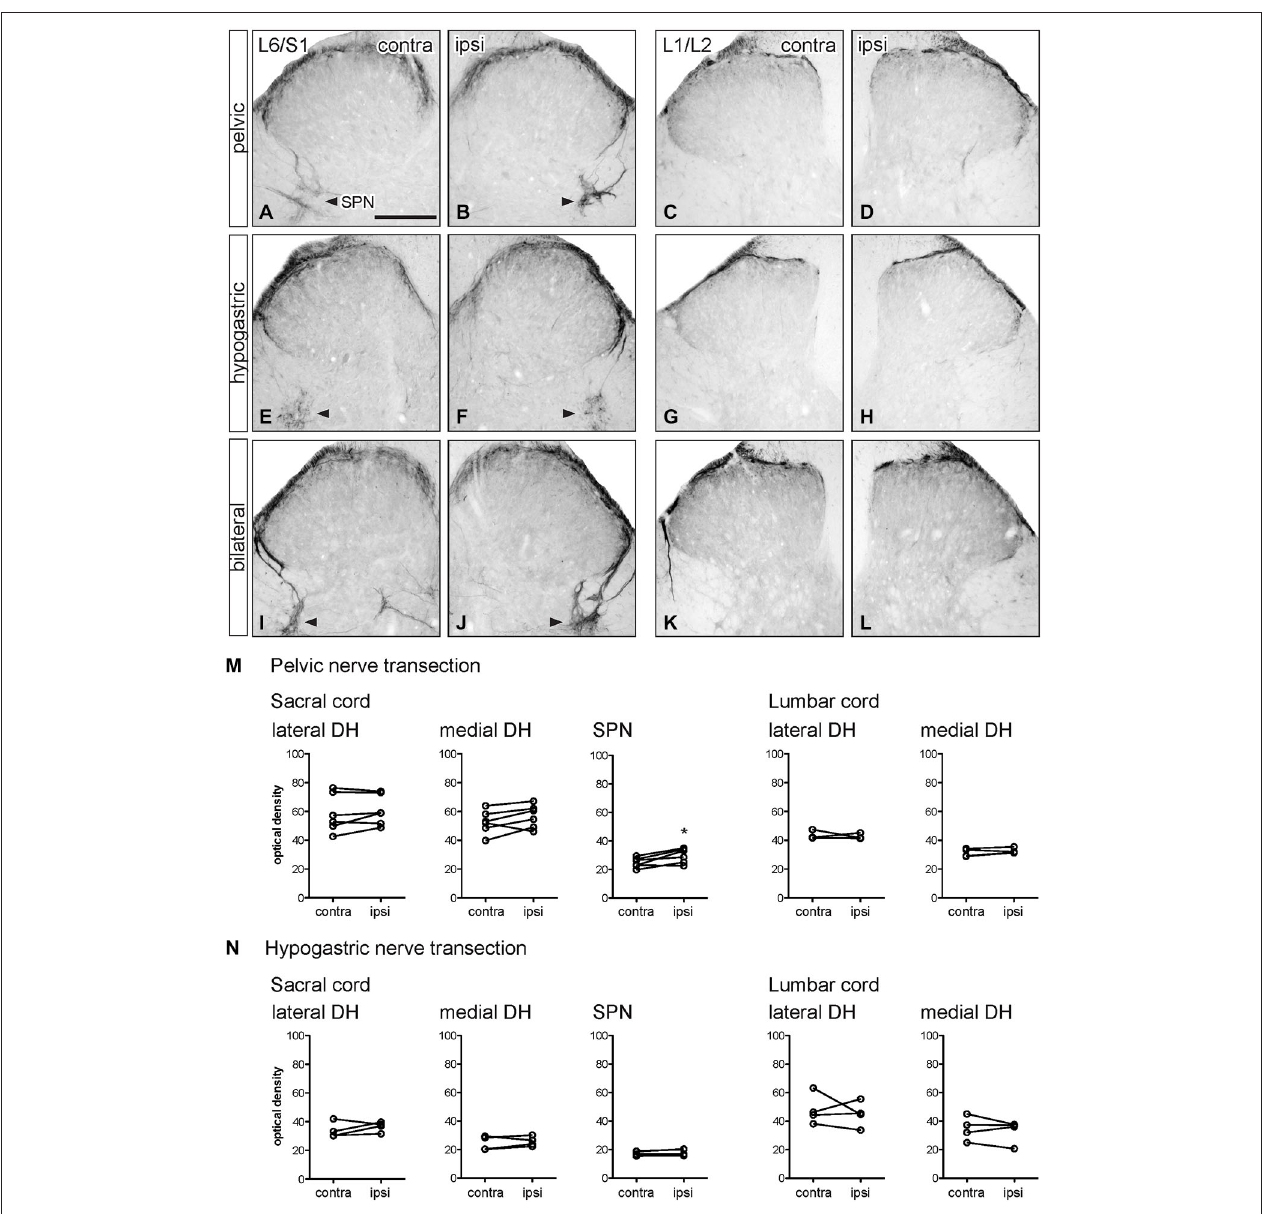
no changes in GFR α 3-IR in sacral dorsal horn, while an increase in GFR α 3-IR was seen in the sacral parasympathetic nucleus (SPN). In lumbar spinal cord, there was no effect of injury on GFR α 3-IR. (N) Hypogastric nerve transection had no effect on GFR α 3-IR in sacral or lumbar spinal cord. Data represents the mean ± SEM ( n = 6 rats for sacral data following unilateral pelvic nerve transection, n = 4 rats for lumbar data following unilateral pelvic hypogastric nerve transection) and was analyzed using a paired t -test. The SPN in sacral cord is indicated with arrowheads (A,B,E,F,I,J) . Scale bar represents 200 µ